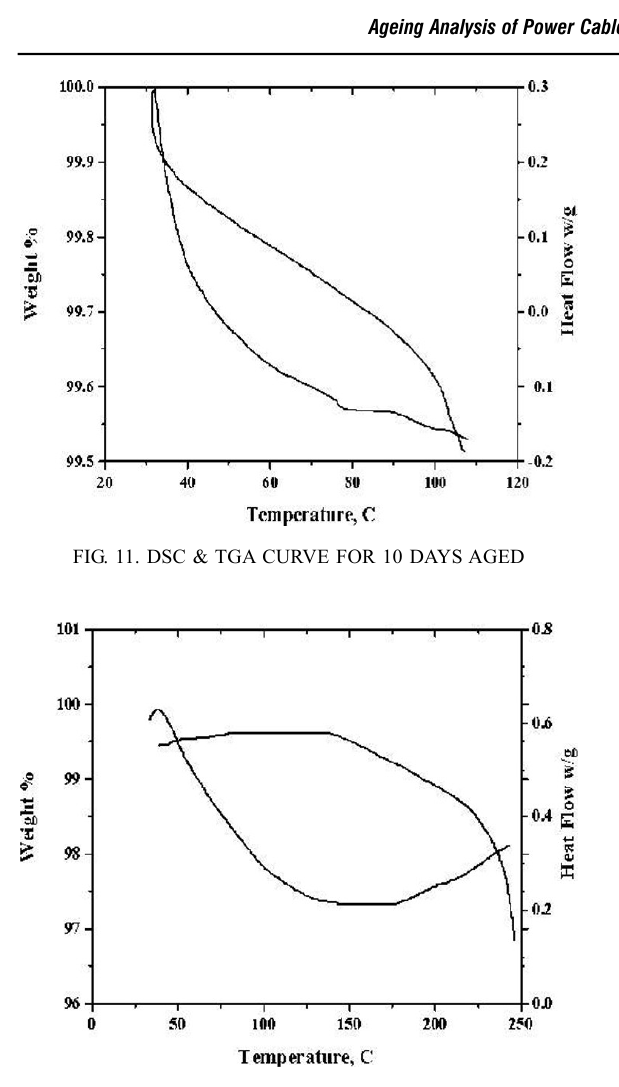
FIG. 14. DSC AND TGA CURVE FOR 10 DAYS AGED SAMPLE (MULTI STRESSED)